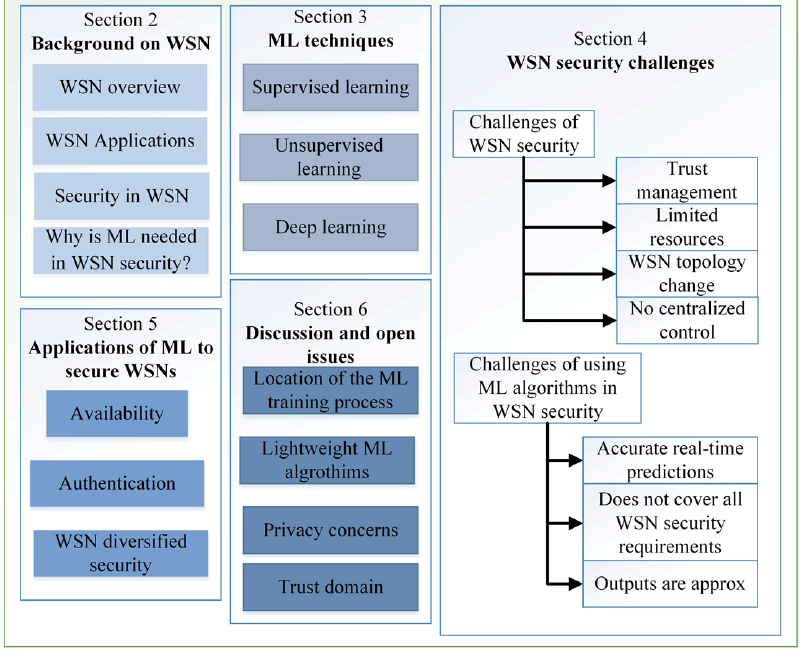
Figure 1. The taxonomy of this survey.